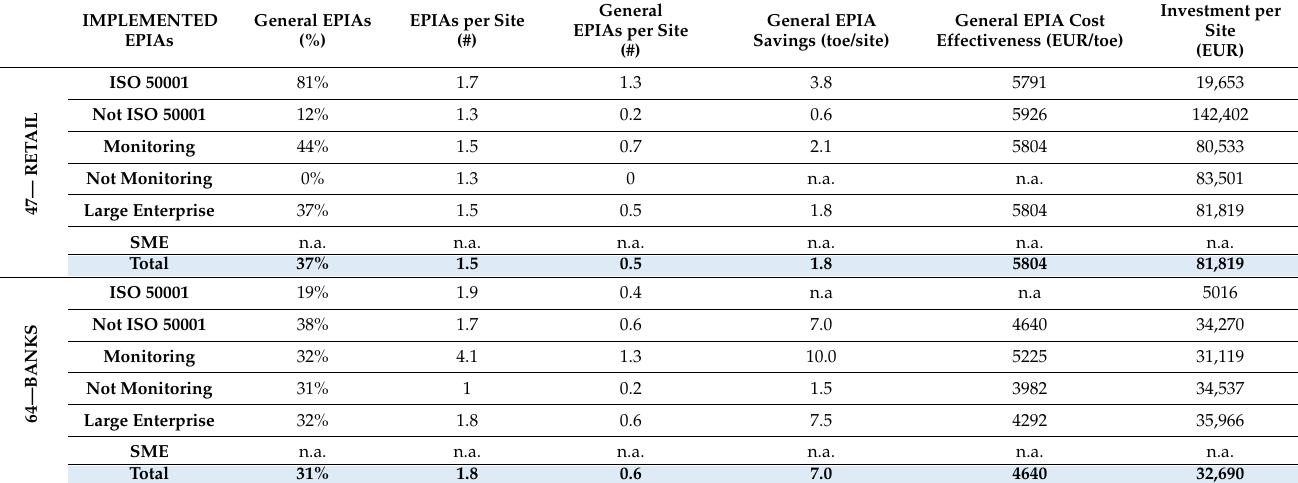
Table 3. Retail and bank sector implemented